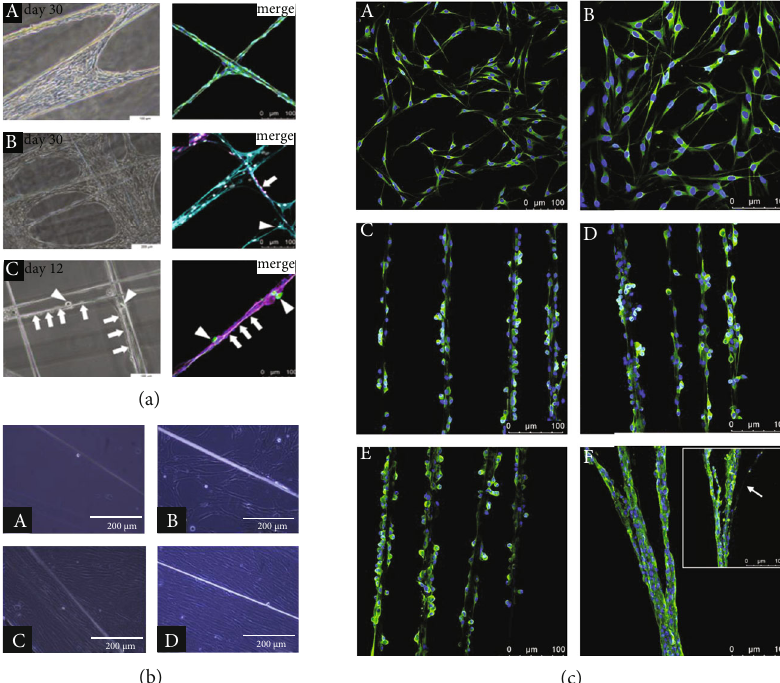
Figure 4: Adhesion of di ff erent cells on spider silk fi bers. (a) Representative phase contrast versus confocal and immunostaining images of (A) rSCs, (B) rFBs, and (C) rDRG neurons cultured on spider silk. The merged channels of rSCs were S100 (green), VIME (grey), and DAPI (blue); the merged channels of rFBs were NGFR (magenta), THY1 (cyan), and DAPI (grey); and the merged channels of rDRG neurons were TUJ1 (beta-3-tubulin) (green), NGFR (magenta), and DAPI (blue). Arrows (left) indicate elongated rDRGs along the silk fi bers, and arrows (right) indicate rFBs and rDRG neuron bodies. Reproduced from F. Millesi et al., 2021, under the Creative Commons Attribution License. (b) Images showed the proliferation and alignment of DPSCs on the spider silk over time (10x magni fi cation). Reproduced from K. Hafner et al., 2017, Copyright © 2021, Elsevier B.V. All rights reserved. (c) Immunostaining images of rSCs cultured on (A and B) PLL/laminin- coated dishes and (C) dragline, (D) cocoon, (E) connecting, and (F) attaching silk showing S100 (green) and DAPI (blue) staining. The white arrow points towards the single silk strands that were barely perceivable. Reproduced from A. Naghilou et al., 2020, under the Creative Commons Attribution